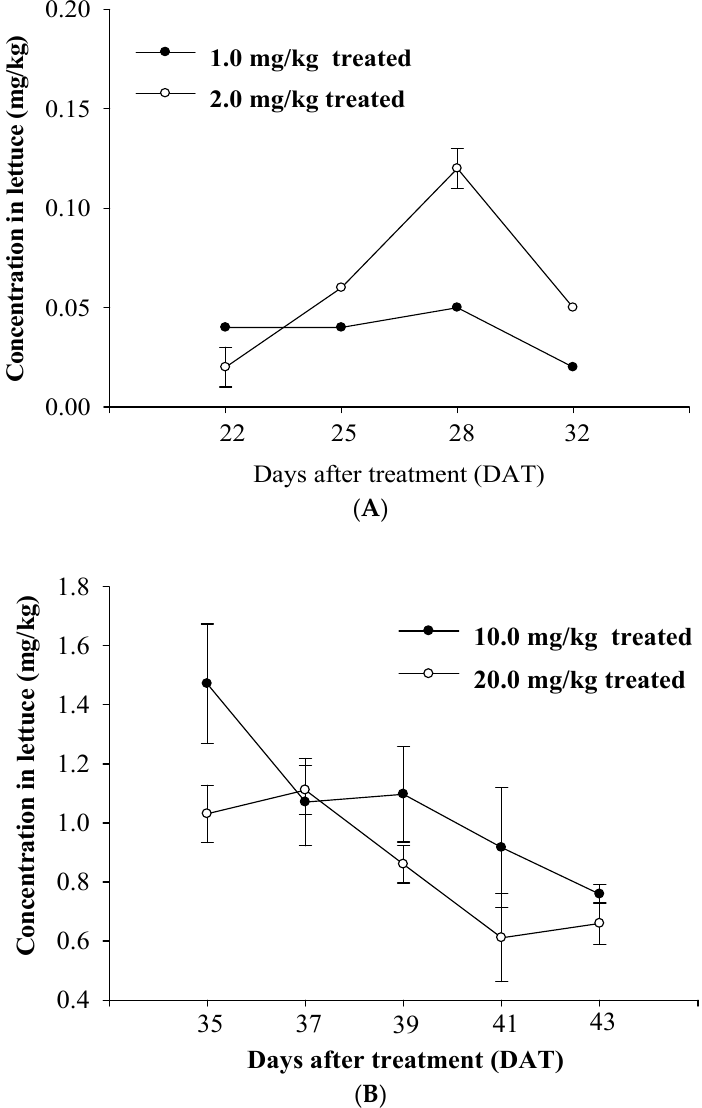
Figure 2. Residual amount of chlorpyrifos in lettuce grown in the treated soils. ( A ) Lettuce samples from field 1; ( B ) Lettuce samples from field 2.